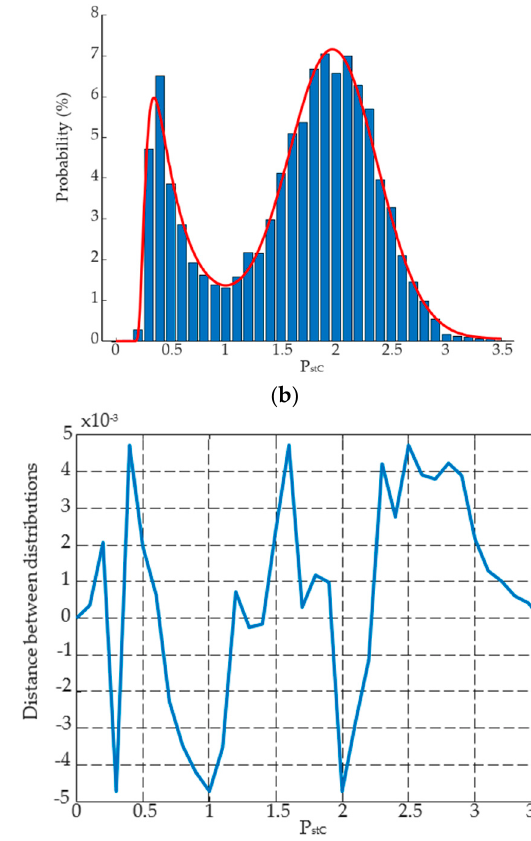
( b ) Figure 9. Relationship between: ( a ) the values of the P st indicatorat points C and B, ( b ) the quotient P stC / P stB and the value of P st from point B.